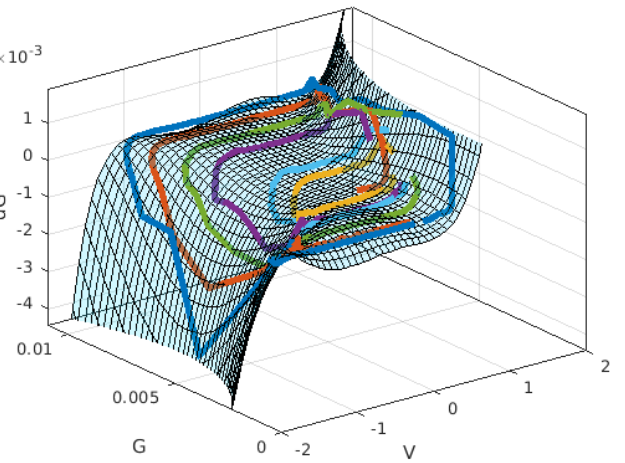
Figure 4. Surface fitting of the data in Figure 3 using a polynomial function. The lines correspond to the measured data, while the mesh corresponds to the